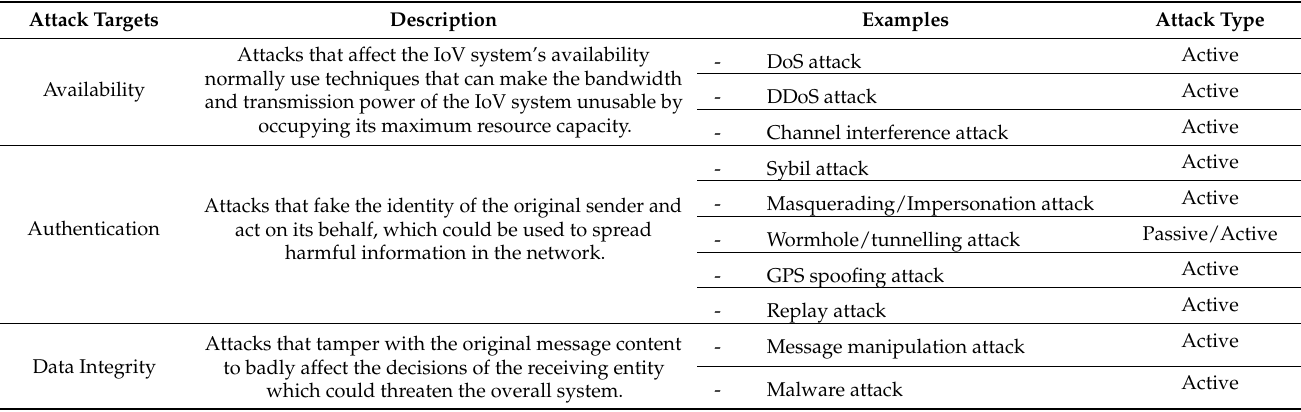
Table 2. Possible security attacks in IoV and VANETs categorized by security